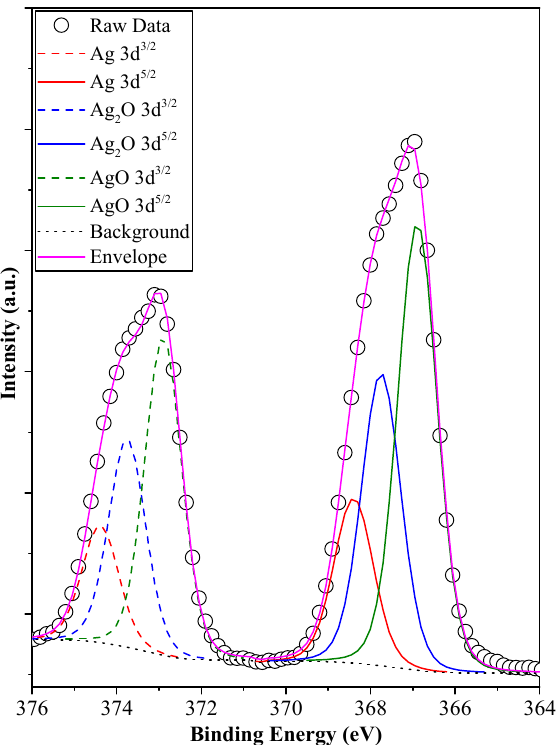
Figure 7. Ag 3d X-ray photoelectron spectroscopy (XPS) spectrum of AgCl_HCl_PVP, showing the Figure 7. Ag 3d X ‐ ray photoelectron spectroscopy (XPS) spectrum of AgCl_HCl_PVP, showing the presence of different silver presence of different silver species.